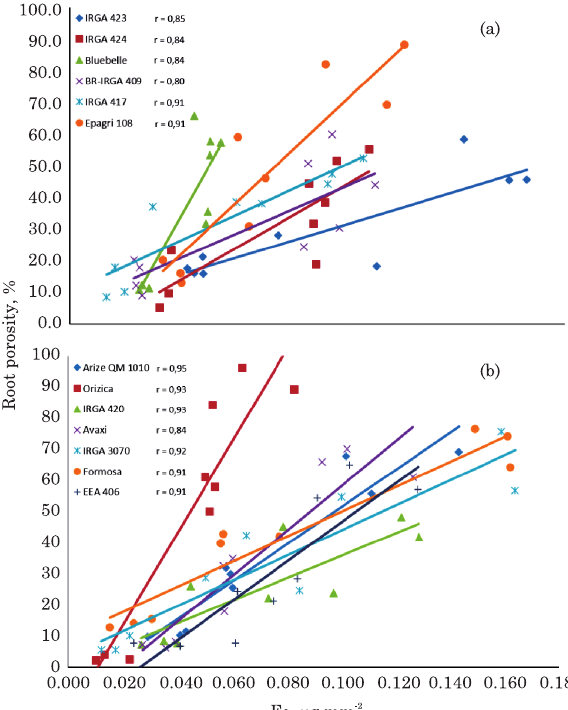
Figure 5. Correlation between porosity and total iron in segments of adventitious roots of rice genotypes (a, b) obtained under hypoxia after four hours of exposure to an Albaqualf soil solution with pH = 6.0 and 80 mg L -1 of Fe.